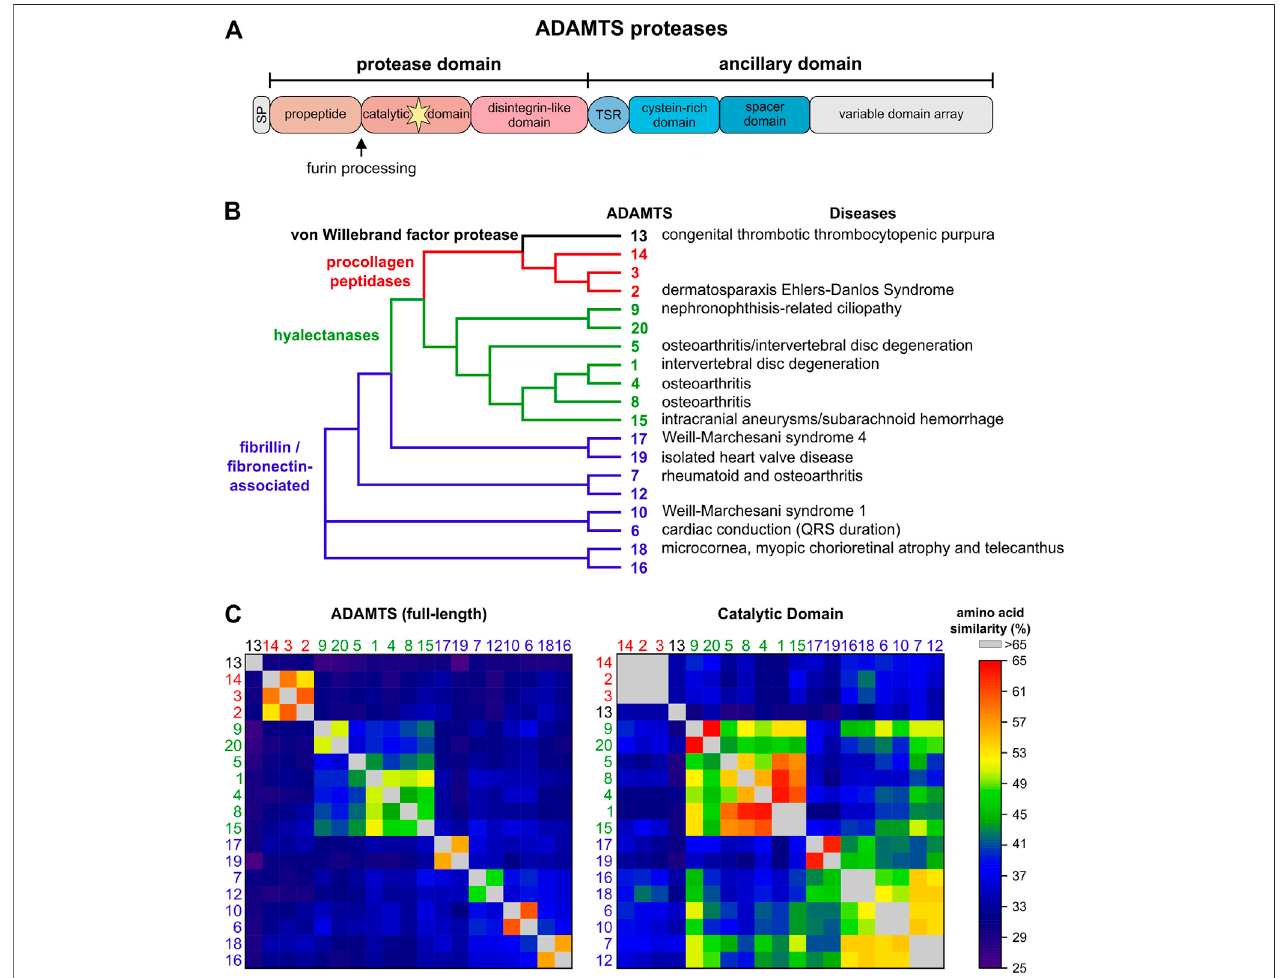
FIGURE 1 | The human ADAMTS protease family. (A) Domain organization of ADAMTS proteases. ADAMTS protease show identical domain organization of the proteasedomainandpartsoftheancillarydomain.TheC-terminalvariabledomainarraysincludebetween0(ADAMTS4)-14(ADAMTS9,ADAMTS20)thrombospondin type Imotif (TSR) domains interspersed withadditional domains unique toADAMTS protease pairs, such asGON1, PLAC or CUBdomains. (B) Phylogenetictree ofthe human ADAMTS proteases generated with Clustal Omega using the full-length protein sequences of the ADAMTS protease (Madeira et al., 2019). Four ADAMTS subfamilies are evident: ADAMTS13 (black), the procollagen peptidases (red), the hyalectanases (green), and ADAMTS proteases associated with cleavage and/or binding to fi brillin and/or fi bronectin (blue). The latter subfamily consists of four distinct pairs of ADAMTS proteases. Disorders associated with individual ADAMTS proteases are indicated on the right. (C) Heat map showing the amino acid similarities offull-length ADAMTS proteases (left) and the respective catalytic domains (right). The full-length ADAMTS proteases cluster in the same groups as indicated in A with little similarities to proteases outside of these groups. These clusters are mainly de fi nedbytheancillarydomainandthepropeptidedomain.However,asimilaranalysisofthecatalyticdomainshowsthataminoacidsimilaritystillseparatesADAMTS13 and the procollagen peptidases but that the boundaries that separated the hyalectanases and the fi brillin/ fi bronectin associated ADAMTS protease are now less well de fi ned. This underscores the challenge of generating speci fi c inhibitors for individual ADAMTS proteases by targeting the catalytic domain.